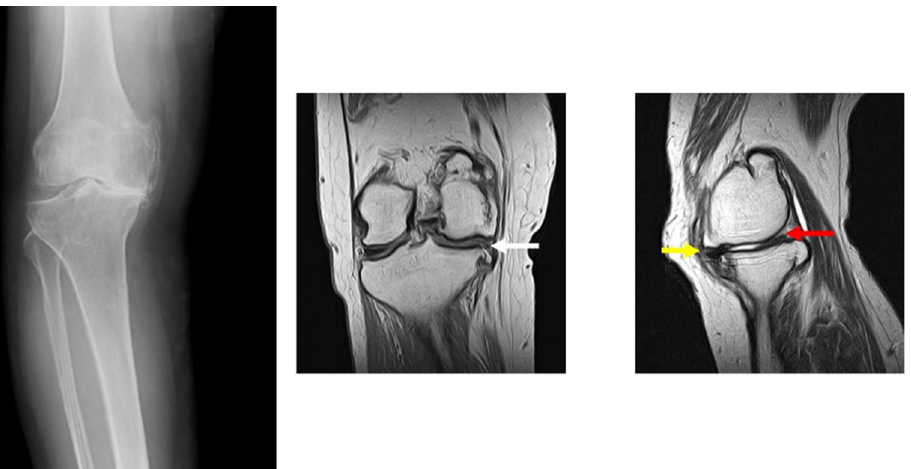
Figure 1. X-rays and MRI images of KOA. X-rays was performed at the load position. MRI shows the results of the coronal plane on the right side and the sagittal plane on the left side. White arrows deviate from the medial meniscus and indicate degenerative rupture. The yellow arrow indicates degeneration of the medial meniscus anterior segment, and the red arrow indicates degeneration rupture of the medial meniscus posterior segment.